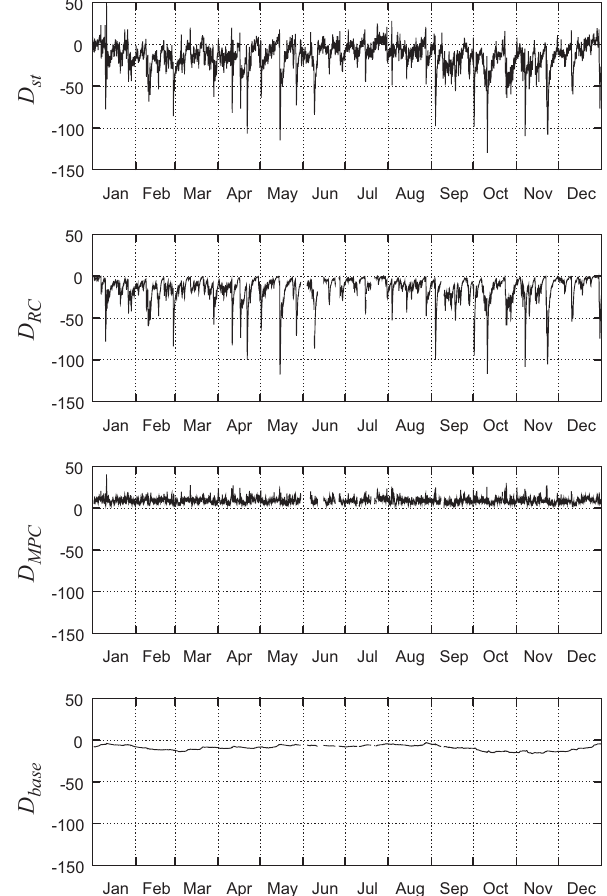
Fig. 4. Variation of the D st index (top panel) and the estimated variations of D RC (second panel), D MPC (third panel), and D base (bottom panel) for one year in